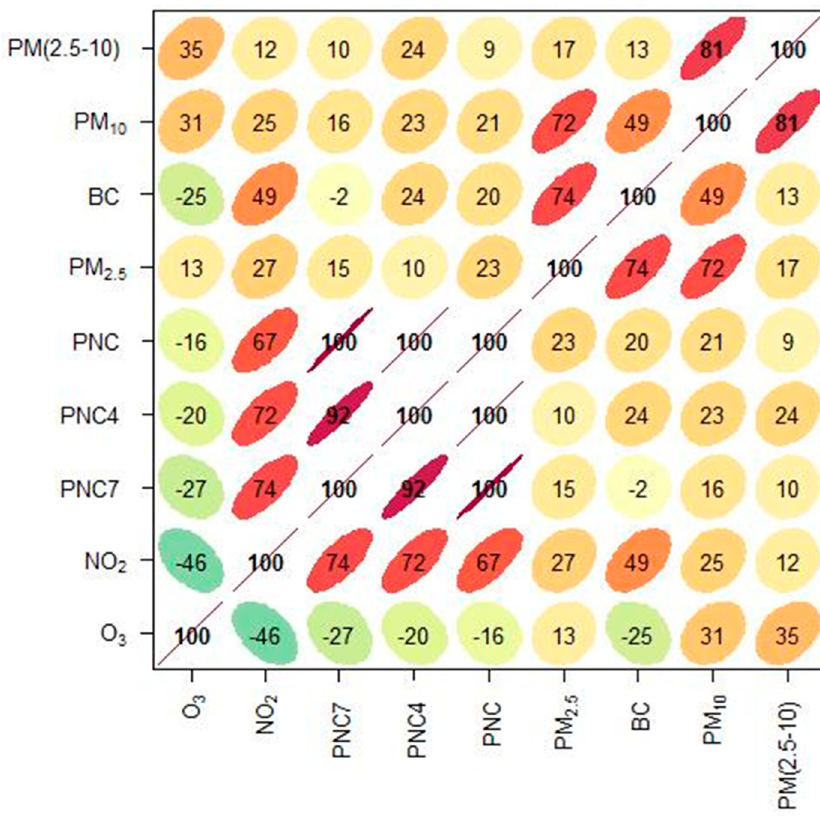
Figure 3. Correlation matrix showing pairwise Pearson correlation coefficients as percentage values. The correlations are illustrated by shapes (ellipses), colors and the numeric value. The ellipses are visual representations of the scatter plots. With a perfect positive correlation, a line at 45 degrees positive slope is drawn. For zero correlation, the shape becomes a circle.